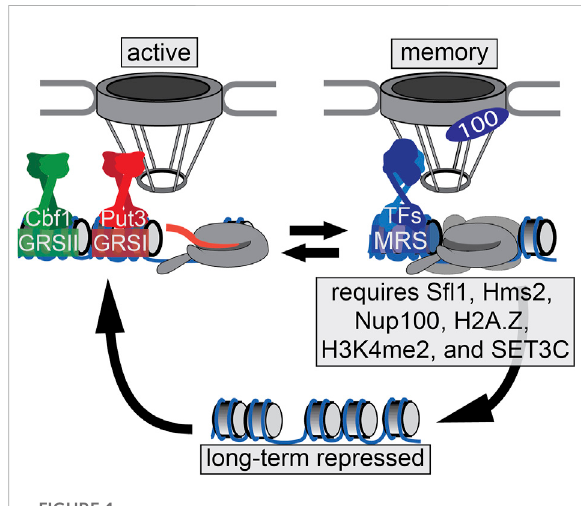
FIGURE 1 INO1 transcriptional states. The INO1 promoter region is depicted. When repressed, INO1 is localized in the nucleoplasm and the chromatin is hypoacetylated and unmethylated. Upon activation, INO1 is recruited the nuclear periphery through Put3- and Cbf1-dependent interaction with the NPC. The promoter and INO1 gene are hyperacetylated and exhibit H3K4me1, H3K4me2, and H3K4me3. Upon repression, INO1 remains associated with the NPC through an S fl 1/Hms2- and Nup100-dependent mechanism. This leads to incorporation of H2A.Z, deposition of H3K4me2 and the recruitment of poised RNAPII pre-initation complex (PIC), which allows more rapid re- activation. H3K4me2 also recruits SET3C, which is essential for